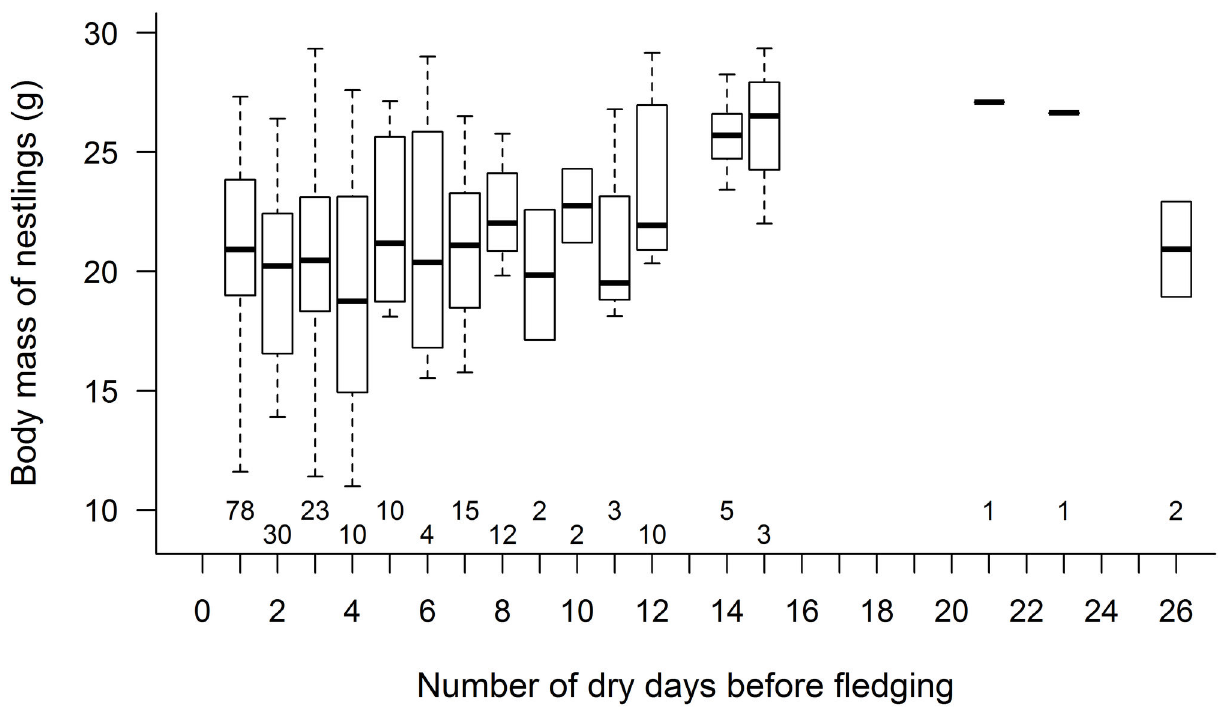
Figure 5. Relationship of nestlings' body mass with the number of dry days before fledging. Box plots show the median (thick line), interquartile range (box) and the range of data (whiskers); sample sizes are shown below each